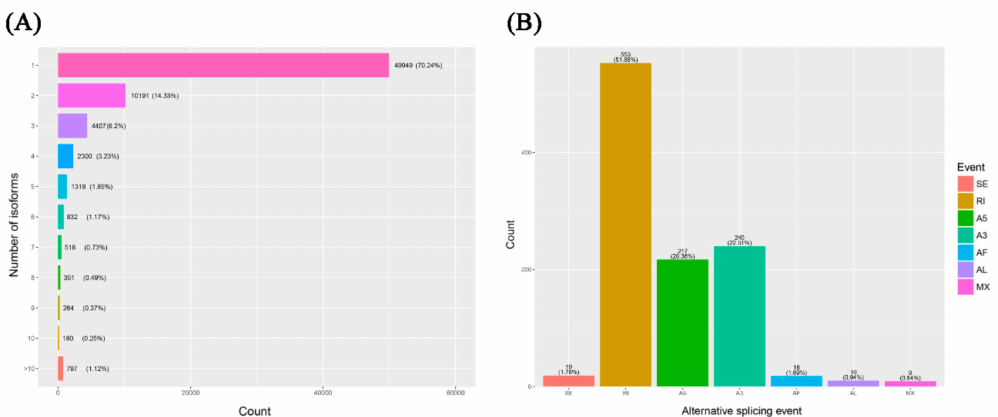
Figure 8. Alternative splicing (AS) analysis of the Lolium multiflorum full-length transcriptome using ISO-seq. ( A ) Distribution of isoform numbers for UniTransModels. ( B ) Numbers of di ff erent AS events detected in full-length transcriptome. SE: skipping exon; RI: retained intron; A5: alternative 5 (cid:48) splice-site; A3: alternative 3 (cid:48) splice-site; AF: alternative first exon; AL: alternative last exon; MX: mutually exclusive